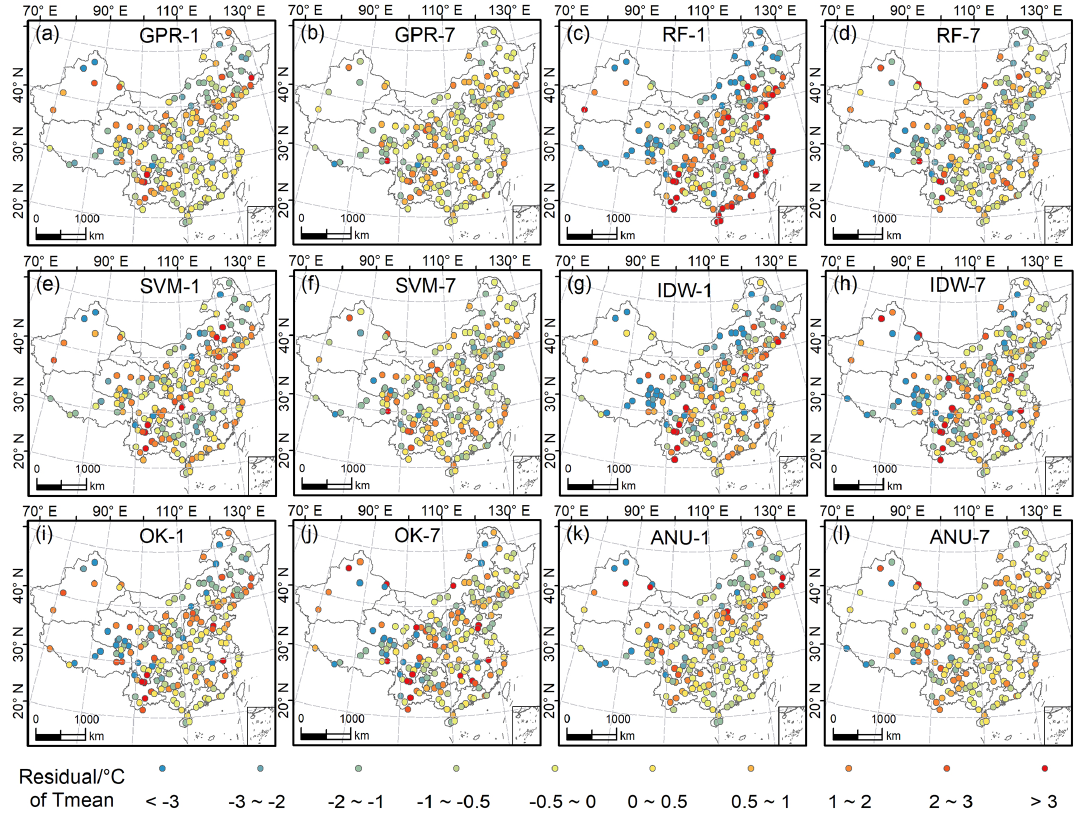
Figure 10. Comparison of the spatial distribution of the residuals between machine learning methods and traditional methods for Tmean in January and July 2020 (comparisons for Tmax and Tmin are provided in Figs. S53 and